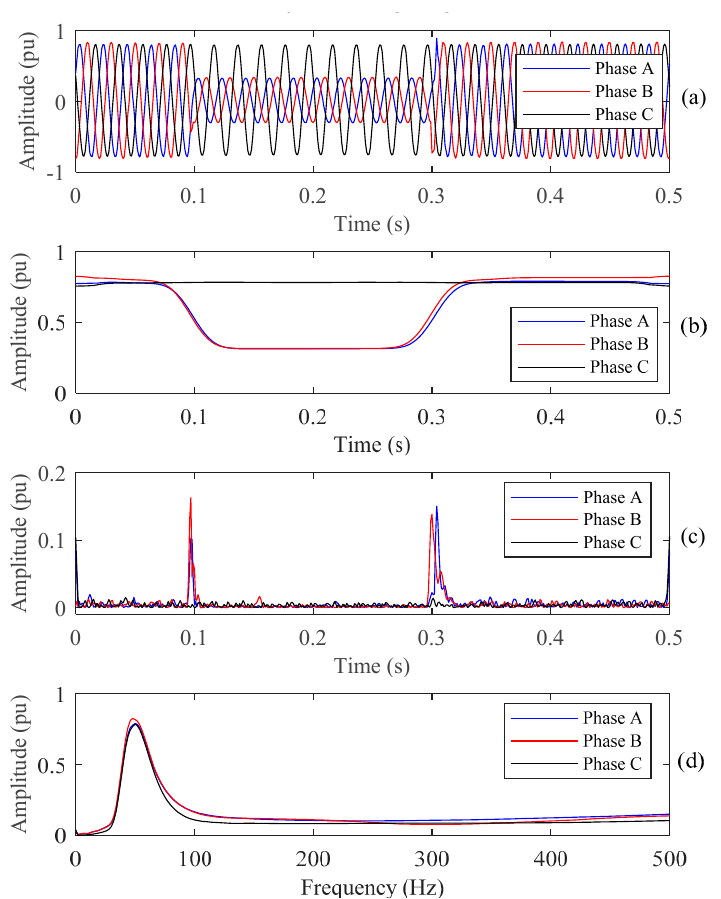
Figure 27. The processing results for the two-phase voltage sag data recorded by Fluke 435 at the laboratory on 2 July 2020: ( a ) actual voltage waveform; ( b ) TvA ; ( c ) TvHFA ; ( d ) FvA .